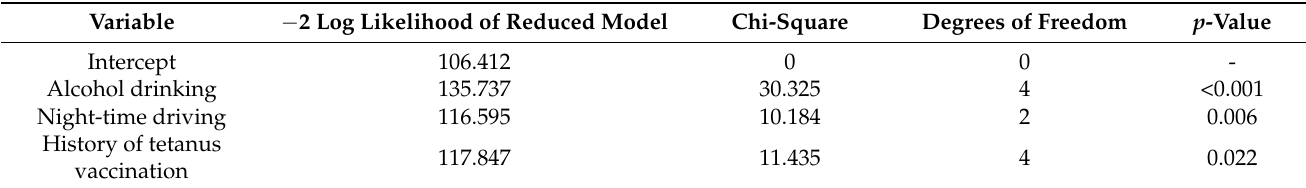
Table 2. Likelihood ratio test.